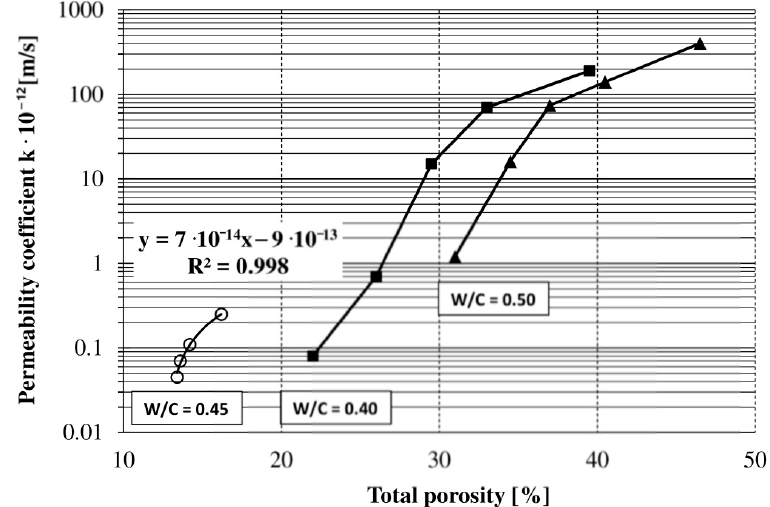
Figure 6. Comparison of the relationship between permeability and porosity for three W / C ratio samples. The measured porosities in the experiments for W / C 0.45 were obtained with two automatic pycnometers. The collection of data regarding permeability as a function of porosity for W / C 0.4 and 0.5 was obtained with mercury intrusion porosimetry